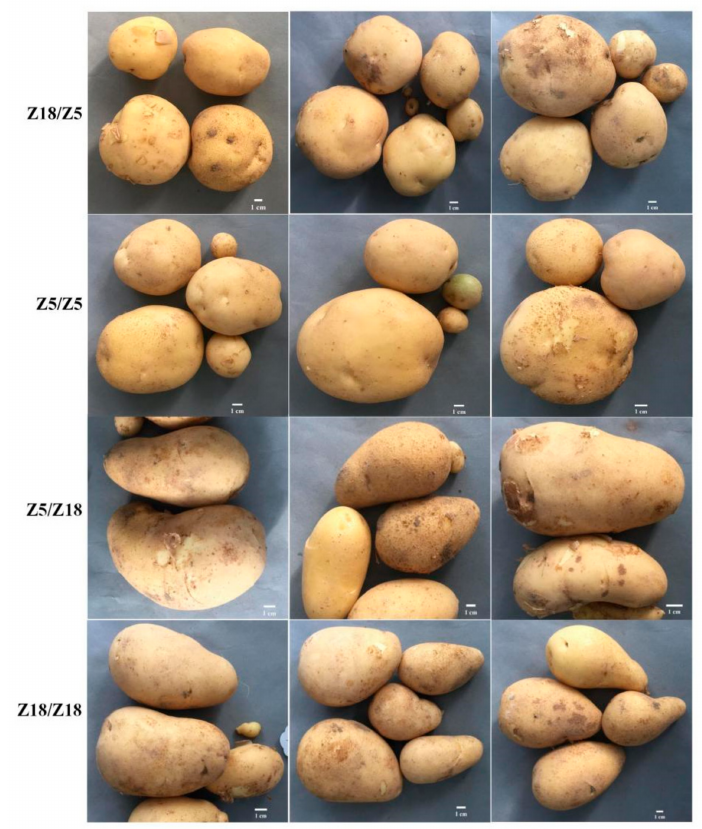
Figure 2. The tuber shape of four grafted combinations: tuber shape of Z18/Z5 and Z5/Z5 grafted plants is round; tuber shape of Z5/Z18 and Z18/Z18 grafted plants is long oval. Bar length is 1